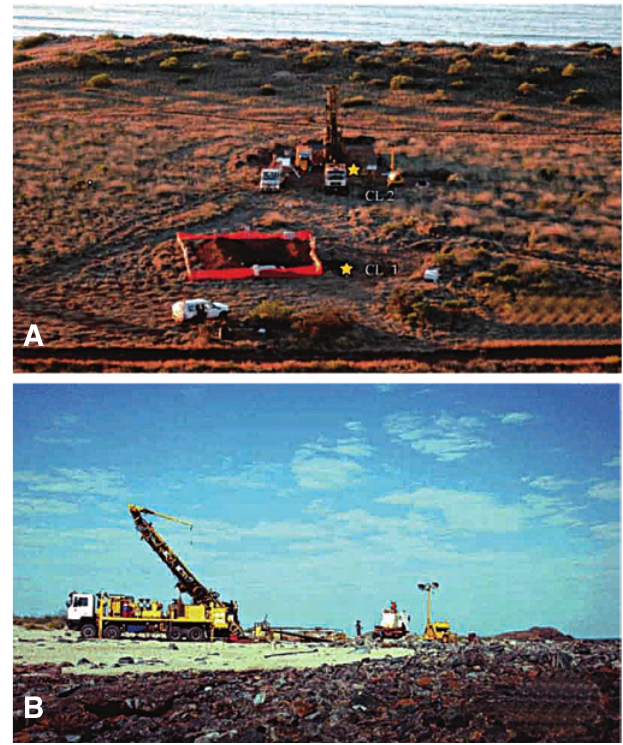
Figure 3. Photographs of drilling sites for DXCL-DP. [A] CL1 and CL2, and [B] DX.